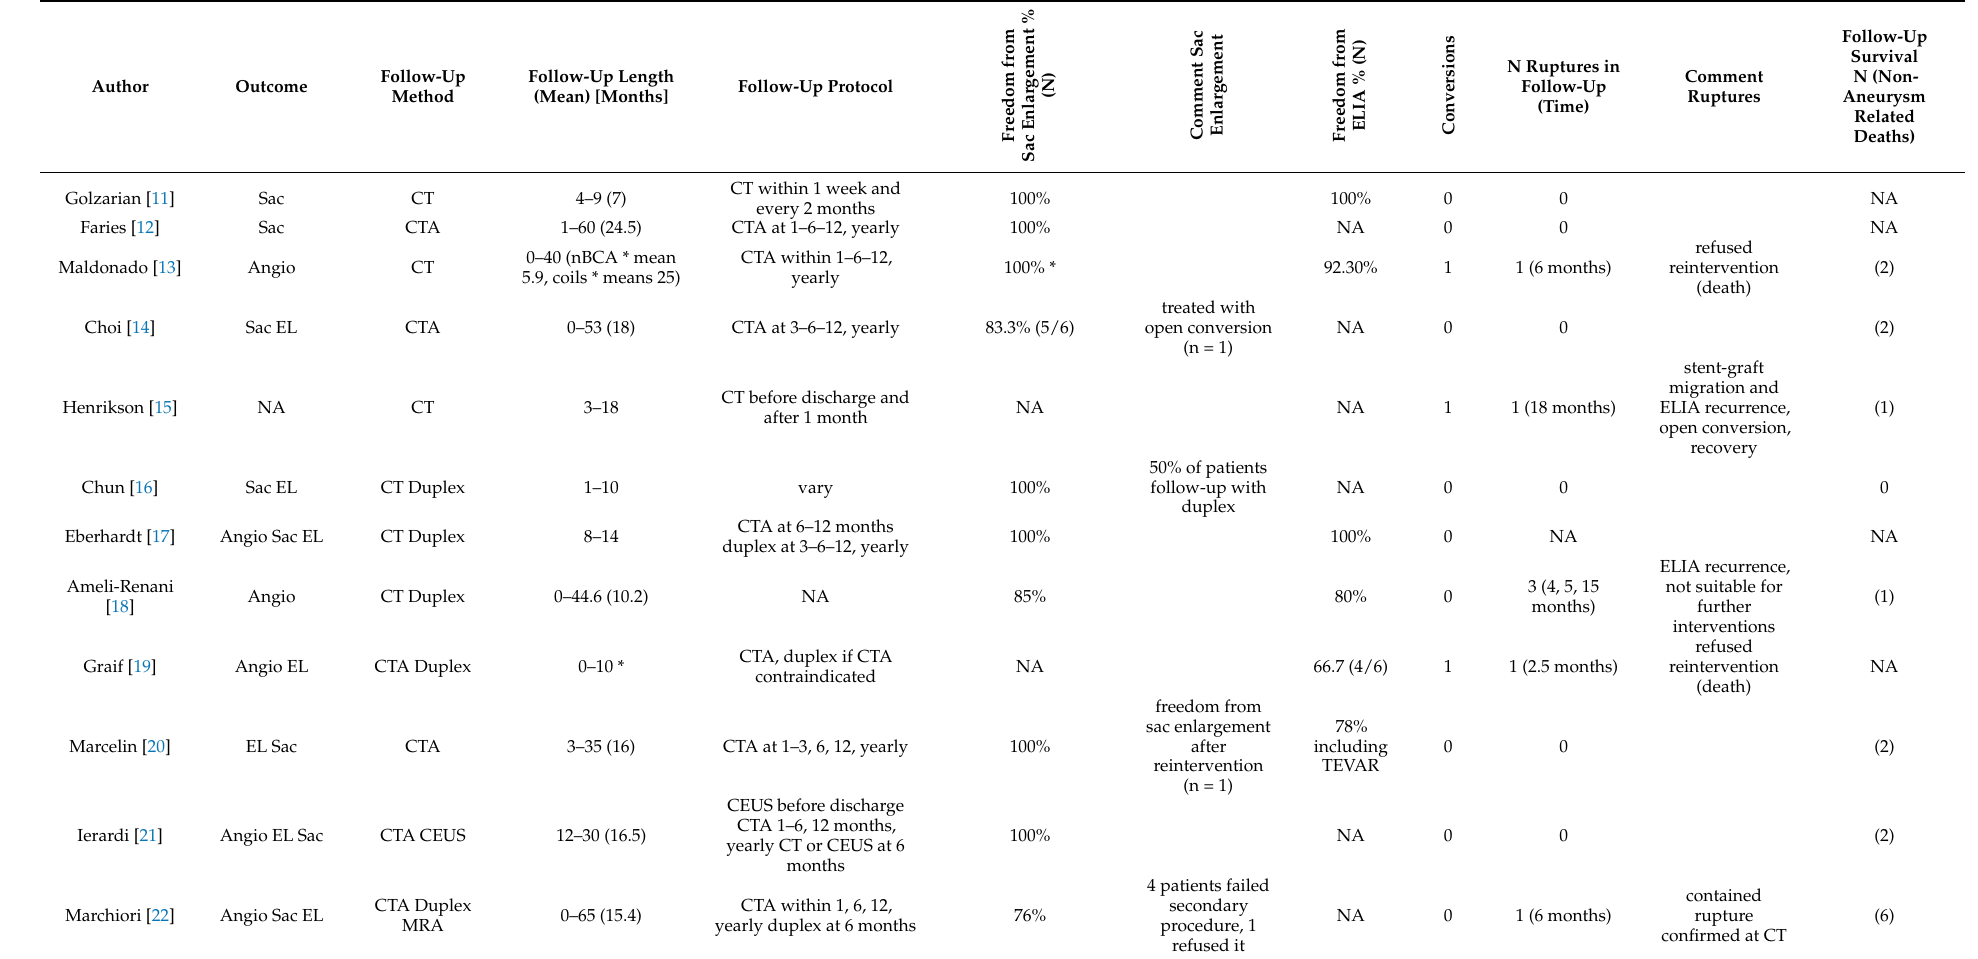
Table 6. Case series: outcomes parameters, follow up methods and timing, follow-up